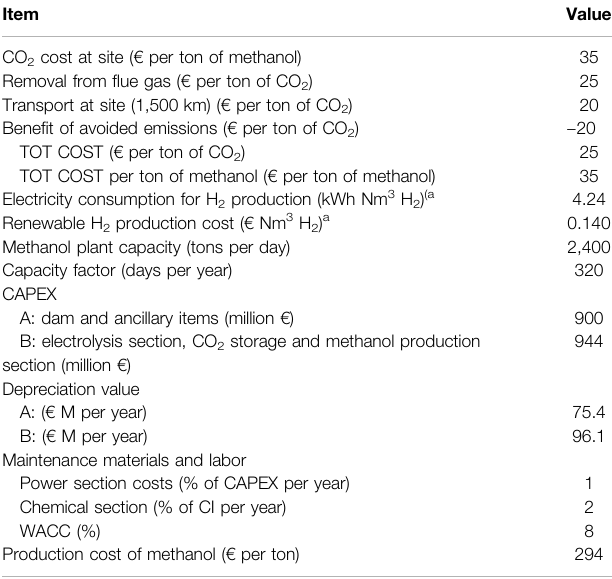
TABLE 1 | Key economic parameters used to estimate the methanol production costs. Reproduced with permission from Barbato et al. (2014).